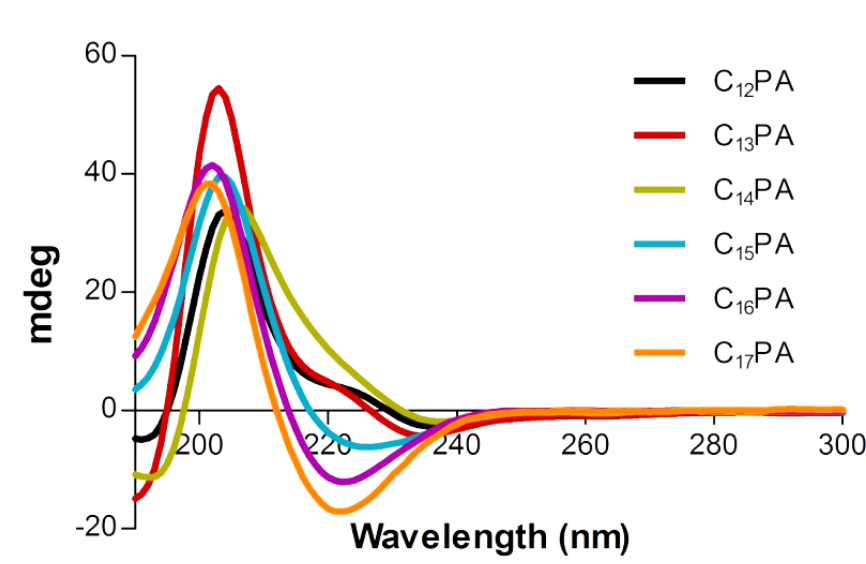
Figure 2. Circular dichroism (CD) spectra of PA assemblies ( 3 × 10 ‒4 M).